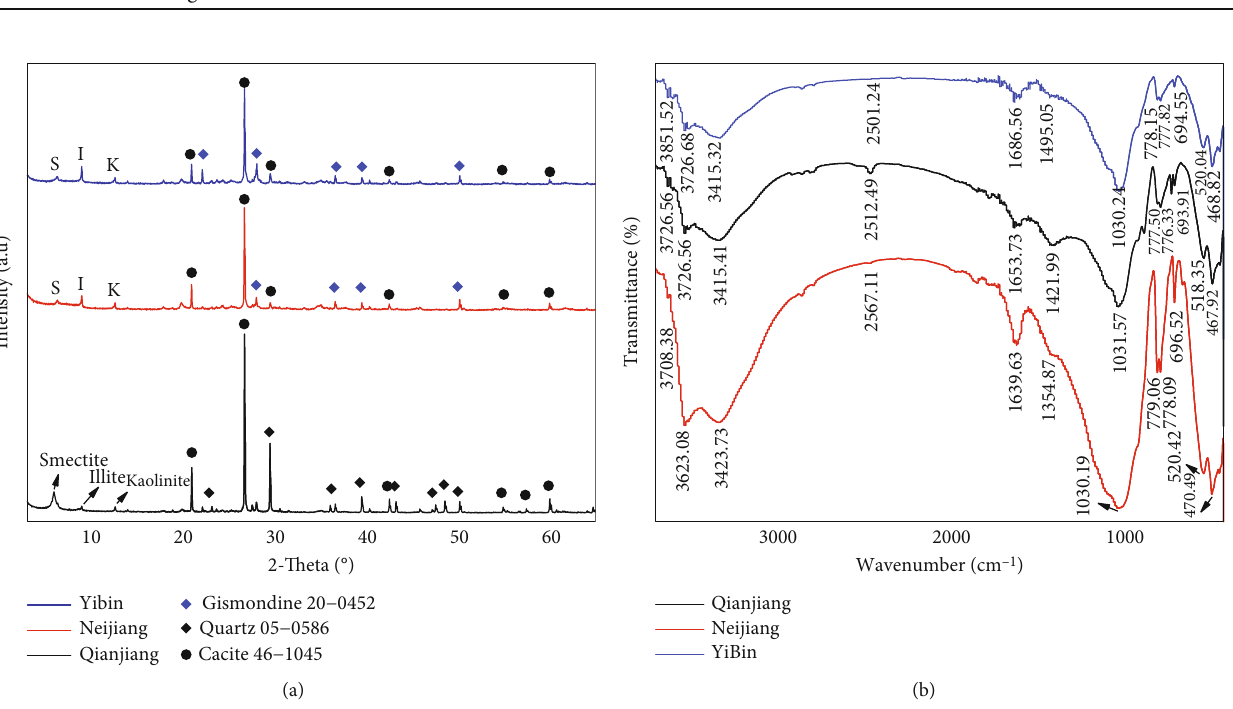
Figure 5: The crystal di ff raction and infrared spectra of the samples: (a) XRD and (b)